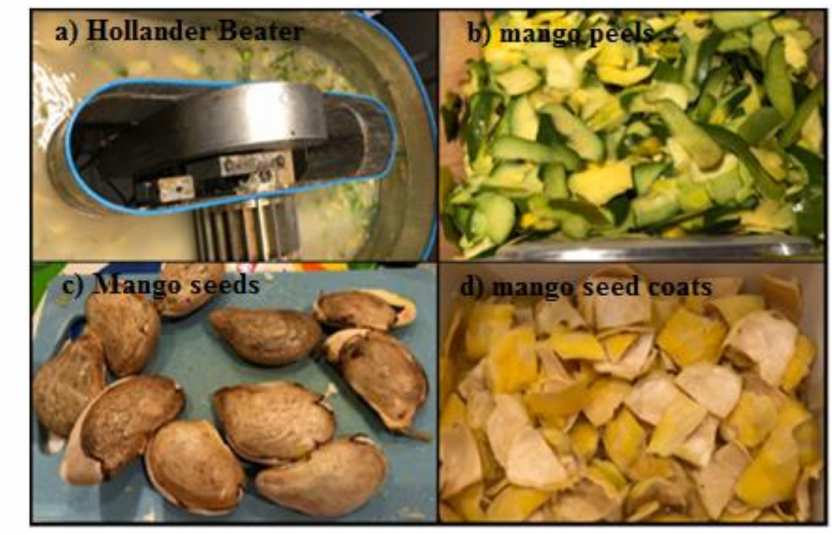
Figure 1. Hollander beater and mango residues, ( a ) Hollander beater, ( b ) mango peels, ( c ) mango seeds, and ( d ) mango seed